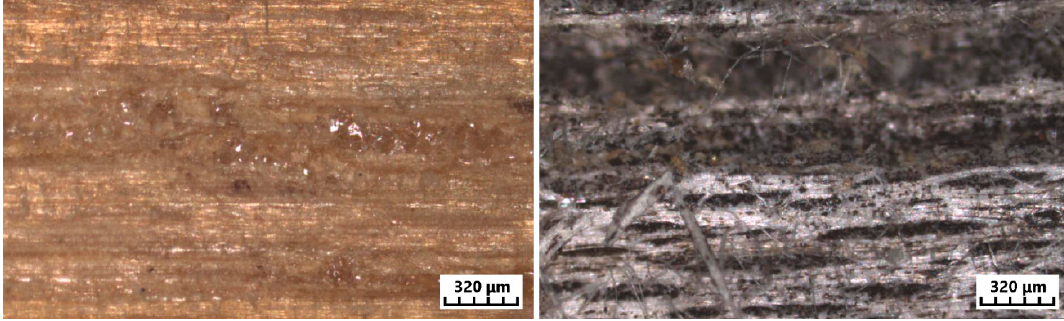
Figure 9. Confocal laser scanning microscopy of black locust wood before and after 2 years of weathering (detail).